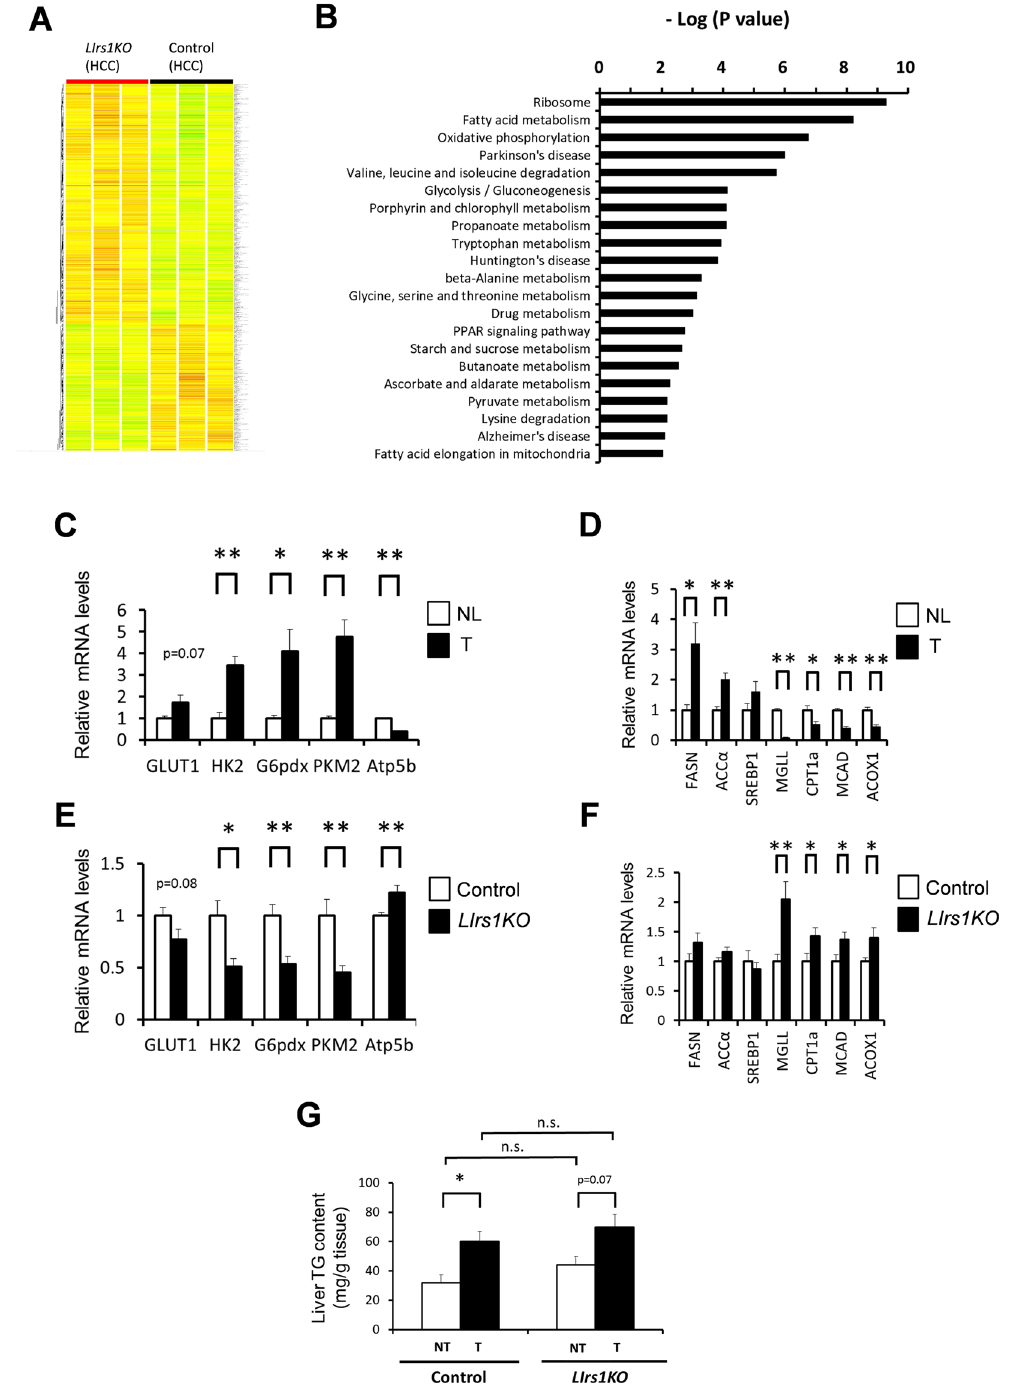
Figure 6. Irs1 appears to be required for promotion of the Warburg effect and change in fat metabolism during hepatocarcinogenesis. ( A ) Microarray analysis and clustering of genes in tumors from DEN-treated LIrs1KO and DEN-treated control mice. The Heatmap showed all genes changed with p < 0.05. Red, upregulated; green, downregulated; yellow, no change (n = 3). ( B ) KEGG pathway analysis was performed with the program DAVID. Pathways changed with p < 0.01 were listed. ( C and D ) RT- PCR analysis of indicated gene expression levels related to enzymes of ( C ) glucose metabolism and ( D ) fat metabolism in tumors (T) and normal livers (NL) (n = 5). ( E and F ) RT- PCR analysis of indicated gene expression levels related to enzymes of (E) glucose metabolism and ( F ) fat metabolism in tumors from DEN-treated LIrs1KO and DEN-treated control mice (n = 10–12). ( G ) The TG content of the tumors (T) and non-tumor tissues (NT) in DEN-treated LIrs1KO and DEN-treated control mice (n = 6). Values are the means ± SEM of data obtained from the analysis of each group. * P < 0.05. ** P < 0.01. (n.s., not significant